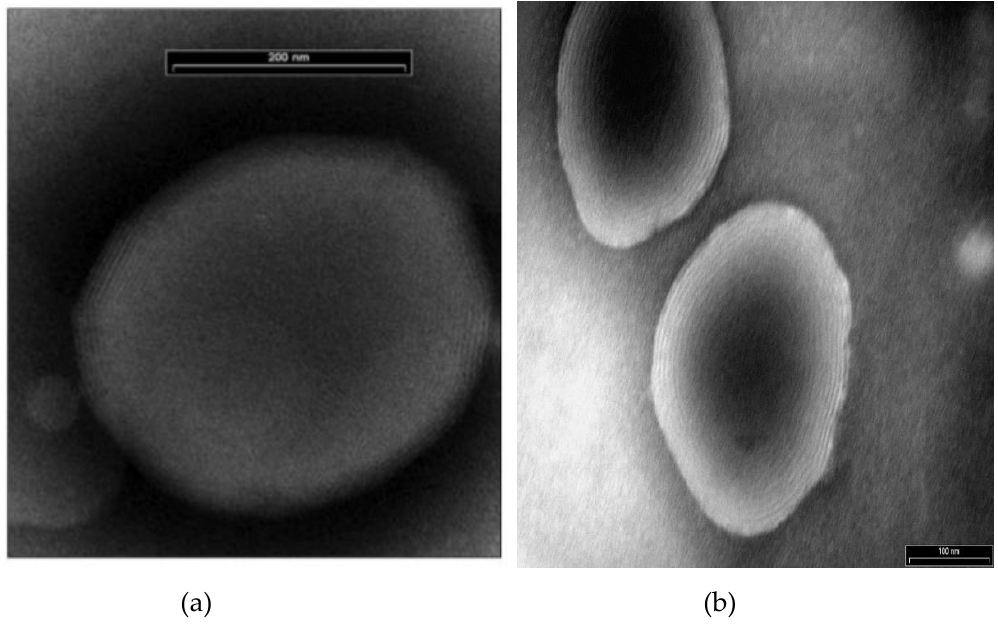
Figure 7. TE micrographs showing the multilamellar structure of: ( a ) Soft vesicular nasal nanocarrier, × 110k, scale bar 200 nm. Reproduced from Reference [10] with permission. ( b ) Phospholipid magnesome × 135k, scale bar 100 nm. Reproduced from Reference [152] with permission.